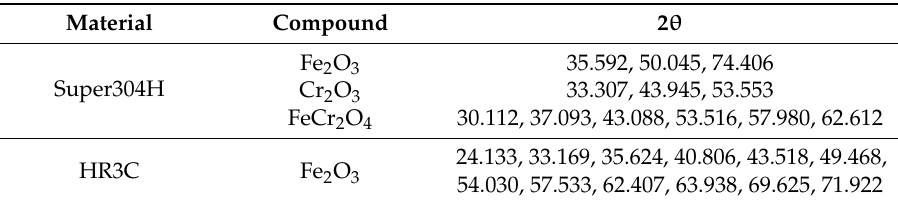
Table 3. XRD data for 2 θ .